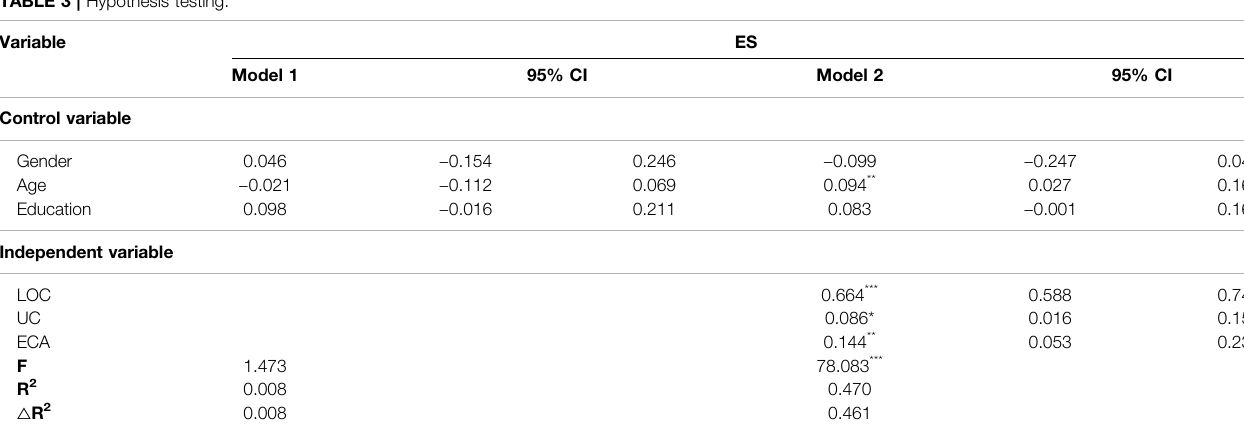
TABLE 3 | Hypothesis